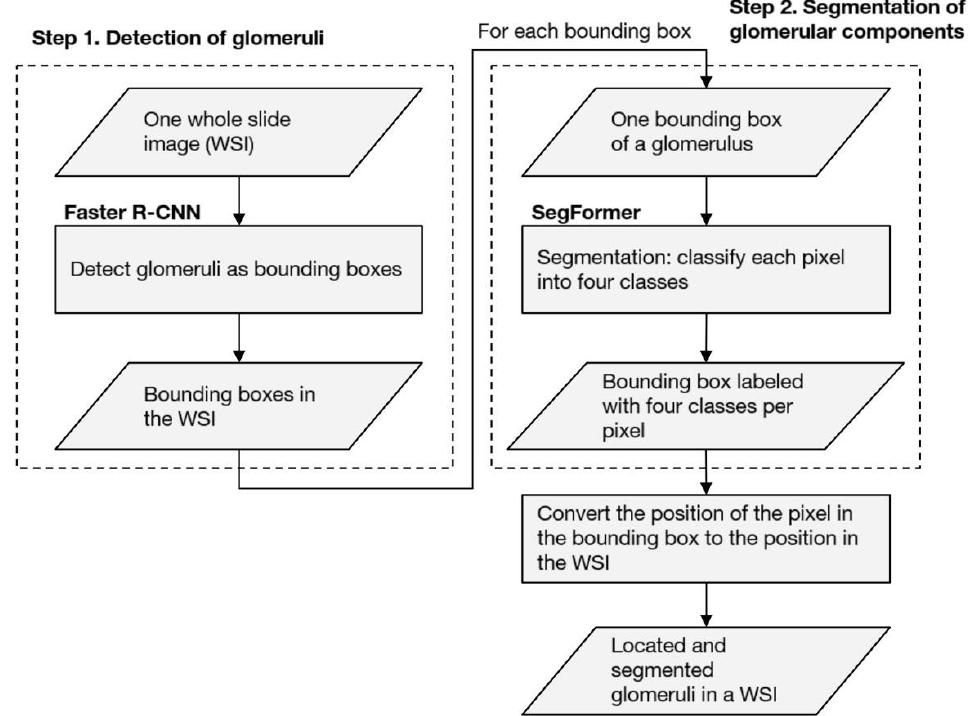
Figure 2. Overview of the computational pipeline. The parallelograms indicate the input or output data. The rectangles indicate the process. Faster R-CNN is described by Ren et al. [25], and SegFormer is described by Xie et al. [26].